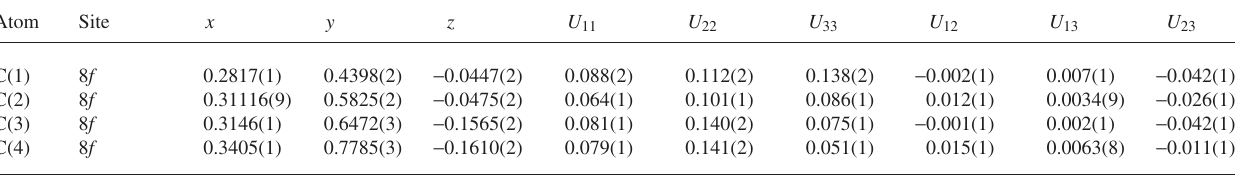
Table 3. Atomic coordinates and displacement parameters (in Å 2 )